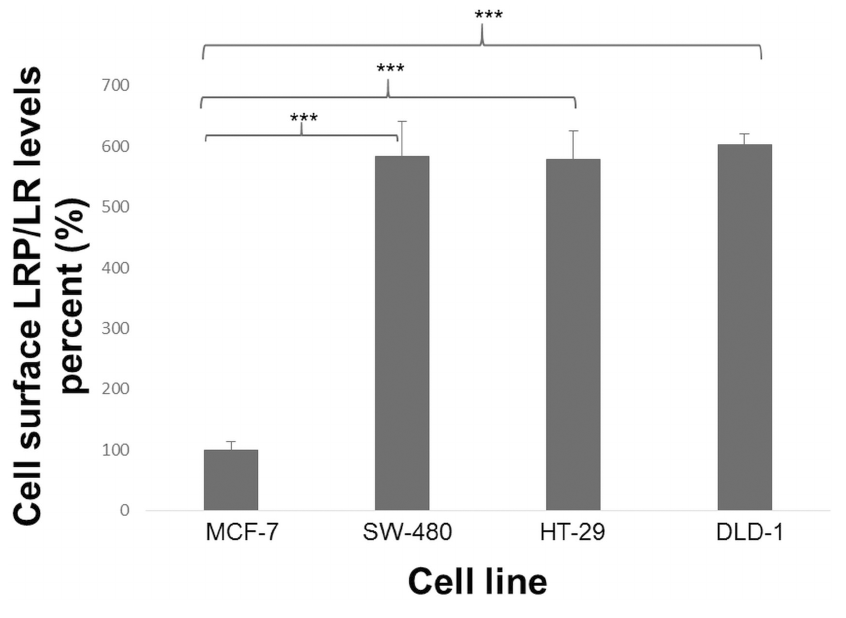
Figure 3. Quantification of cell surface LRP/LR levels on tumorigenic cell lines. Cells were labeled with IgG1-iS18 primary antibody and antihuman phycoerythrin–coupled second- ary antibody. Thereafter, 20,000 cells from each tumorigenic cell line were analyzed and fluorescence intensities were used to indicate cell surface LRP/LR levels. These data rep- resent experiments performed in triplicate using different cell higher amounts of LRP/LR within a cell population compared with the MCF-7 cells. However, when comparing the col- orectal cancer stages to one another, no significant difference was observed (see Supplementary Figure S1).